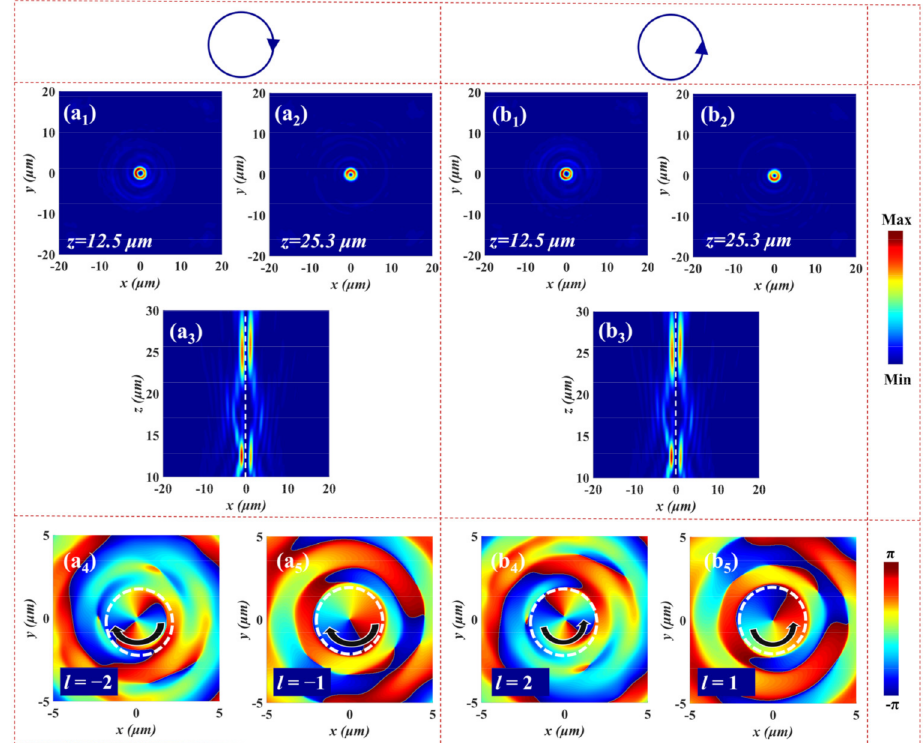
Figure 7. The simulated electric field intensity distributions of FOVs at the focal plane for ( a 1 , a 2 ) LCP and ( b 1 , b 2 ) RCP. The electric field intensity profiles of FOVs in the x-z plane upon the illumination with ( a 3 ) LCP and ( b 3 ) RCP. The corresponding phase distributions in the x-z plane at the focal plane under ( a 4 , a 5 ) LCP and ( b 4 , b 5 )